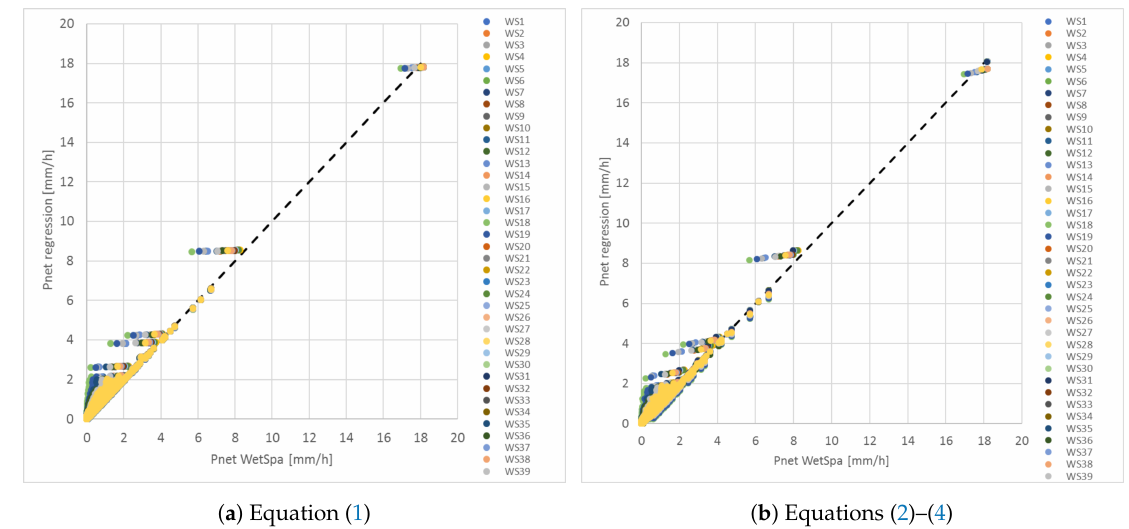
Figure 4. Pnet regression: ( a ) in one step ( b ) with subdivision for the 39 sub-catchments (WS) of the Watermaelbeek.